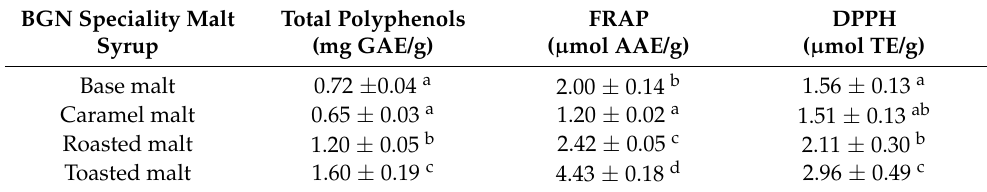
Table 7. Total polyphenols and antioxidant activities of Bambara speciality malt syrups 1 . BGN Speciality